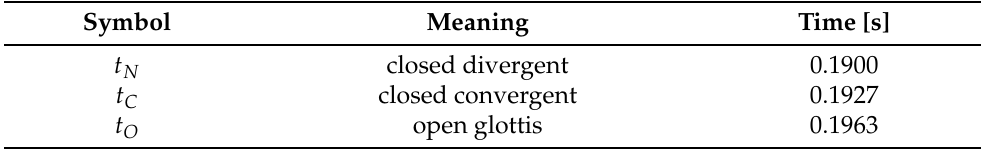
Table 2. Time instants used in the presentation of